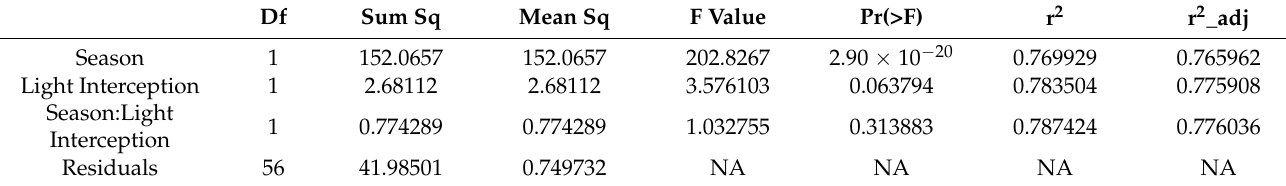
Table A18. Colour